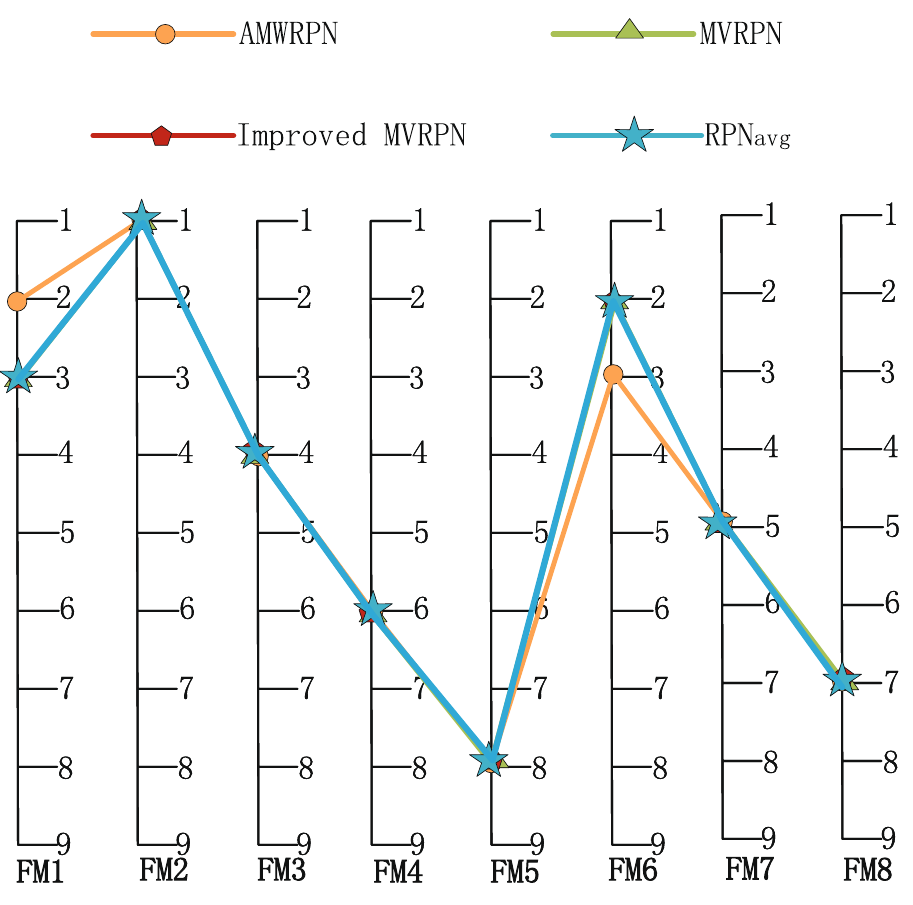
Figure 3. The ranking result of